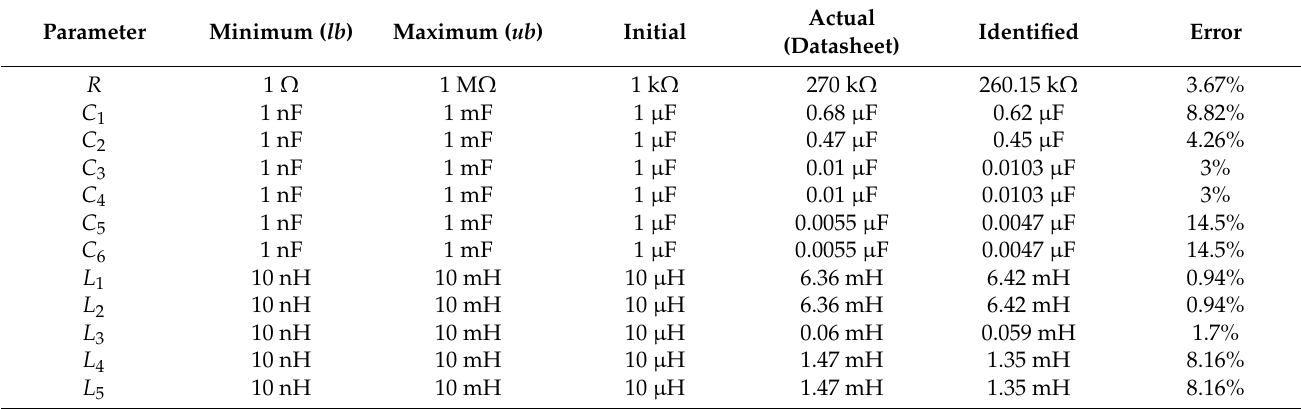
Table 2. Optimization conditions of the NLS identification algorithm of the EMI filter and comparison of actual and identified parameters.